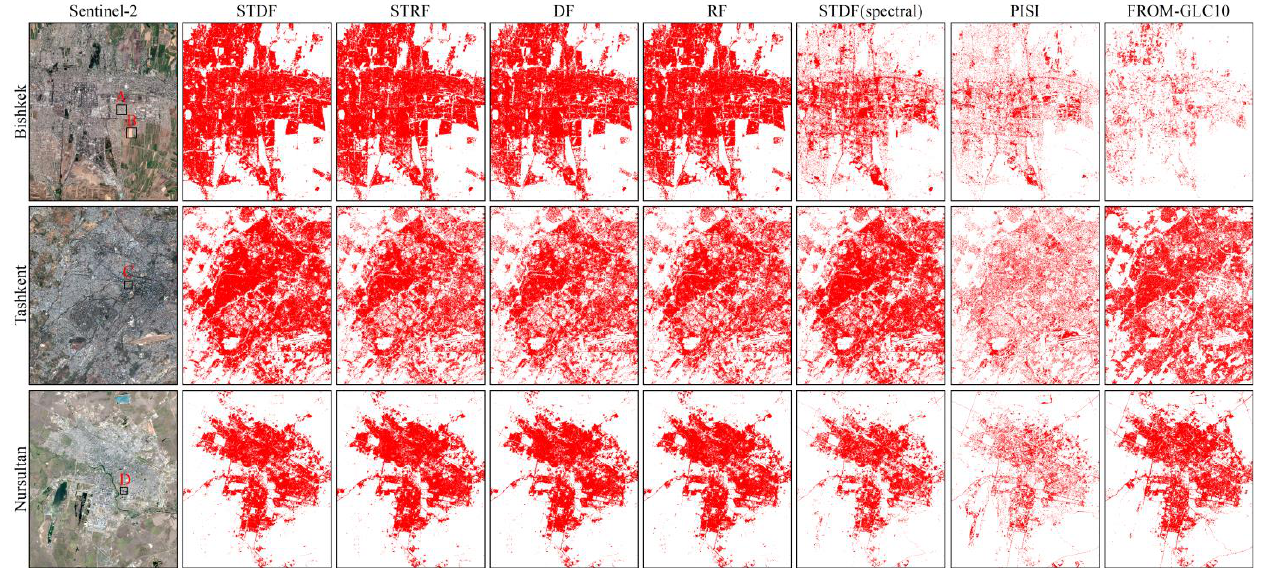
Figure 5. ISA extraction results for seven methods in three areas. Red indicates ISA. Areas A, B, C, and D are the areas with obvious differences between different methods. Table 3. Classification accuracy results for six methods.